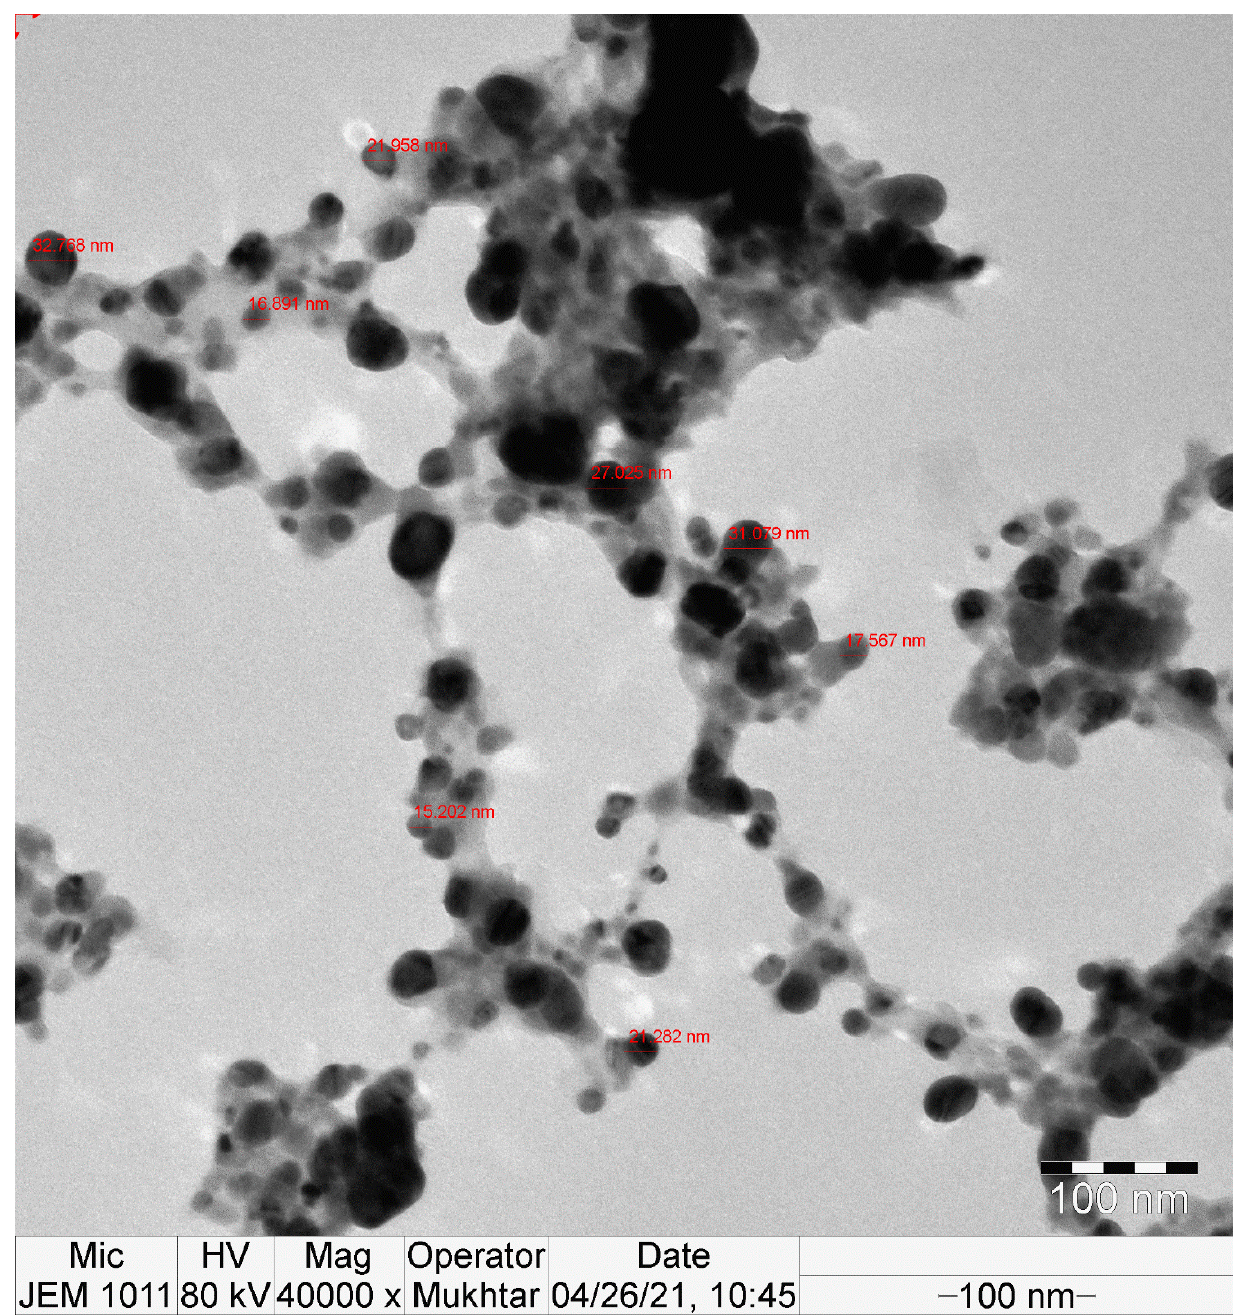
Figure 3. TEM micrograph of the biogenic AgNPs formulated using O. majorana extract.